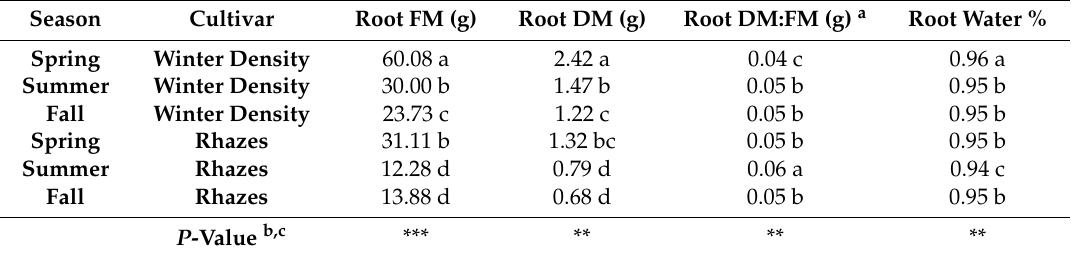
Table 2. The effect of the interaction of season and greenhouse lettuce cultivars on root fresh mass, dry mass, dry mass to fresh mass ratio, and water content.